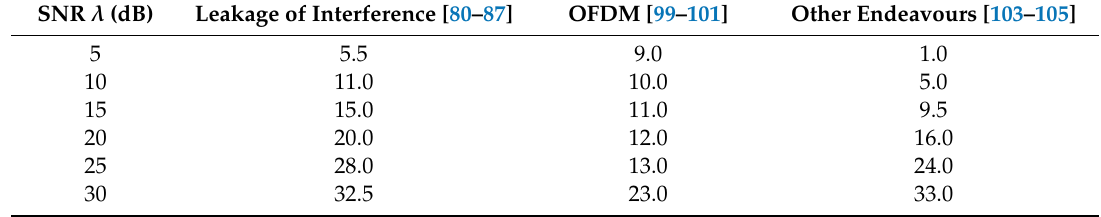
Average Sum Rates of the SU Network Based on the IA Techniques (bits / s / Hertz)